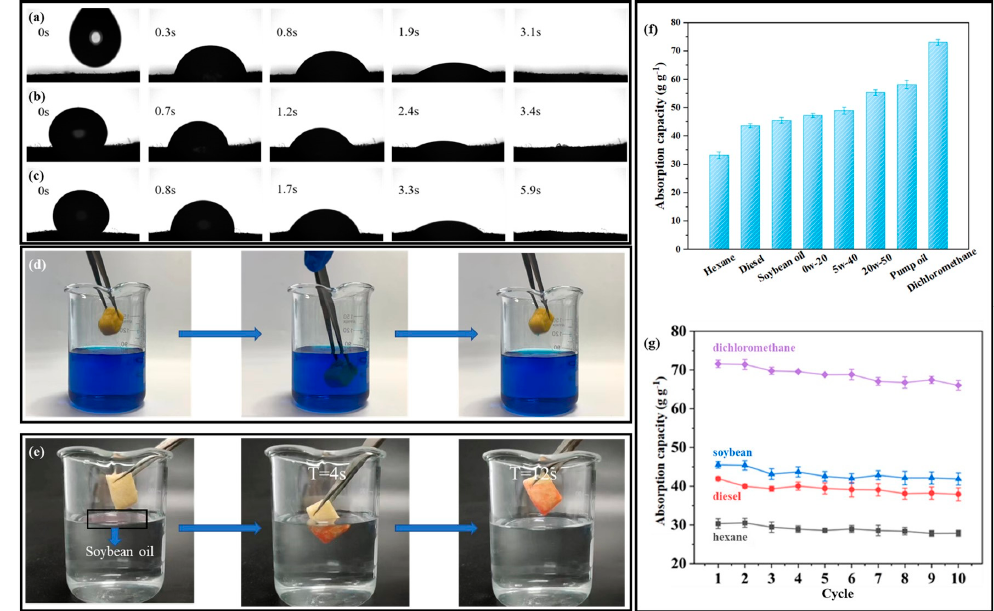
Figure 5. The images of S − PC/CS absorbing ( a ) soybean, ( b ) motor oil 0W − 20, and ( c ) motor oil 5W − 40. ( d , e ) Hydrophobic performance test. ( f ) Sorption capacity (as related to the liquid) and ( g ) Sorption capacity as related to the liquid and the multiple cycles.